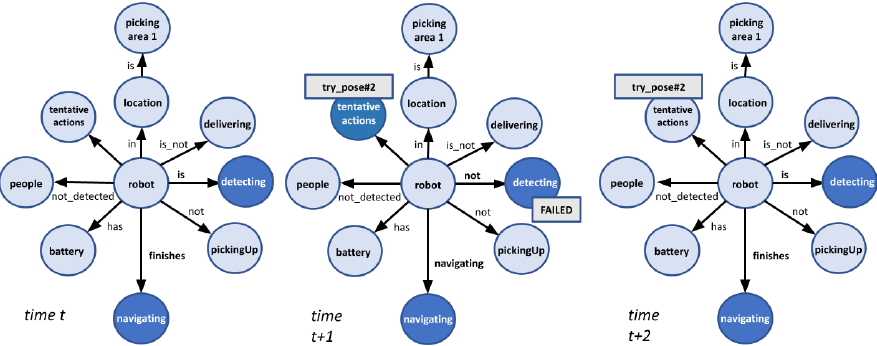
Figure 13. Modification of the nominal course of action: The robot arrives to a picking area but it does not detect the roll container from the observation pose #1 and then navigates to the observation pose #2 to relaunch the